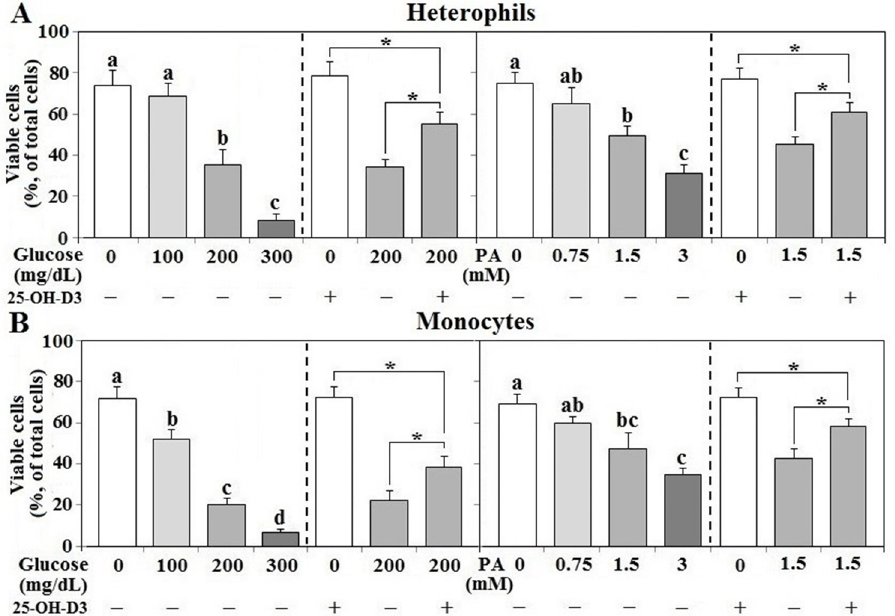
Figure 9. Effects of 25-OH-D 3 on glucose or palmitic acid challenged leukocyte survival. Peripheral leukocytes (1 × 10 6 cells) isolated from R-hens at age 61–65 weeks were cultured with indicated levels of glucose or palmitic acid (PA) in the presence or absence of 25-hydroxycholecalciferol (25-OH-D 3 , 50 nM) overnight (16 h). Collected cell were used for cell death analysis ( n = 4). Means with different letters differ significantly among different levels of glucose or PA ( p < 0.05). Means with different letters differ significantly ( p < 0.05). *, significant difference vs. corresponding control ( p < 0.05). Means with different letters differ significantly ( p < 0.05). + or − indicates with or without PA, glucose, or 25-OH-D 3 . Figure 9 is for cell death analysis, ( A , B ) mean different cell types, ( A ) heterophils, ( B ) mpnocytes.